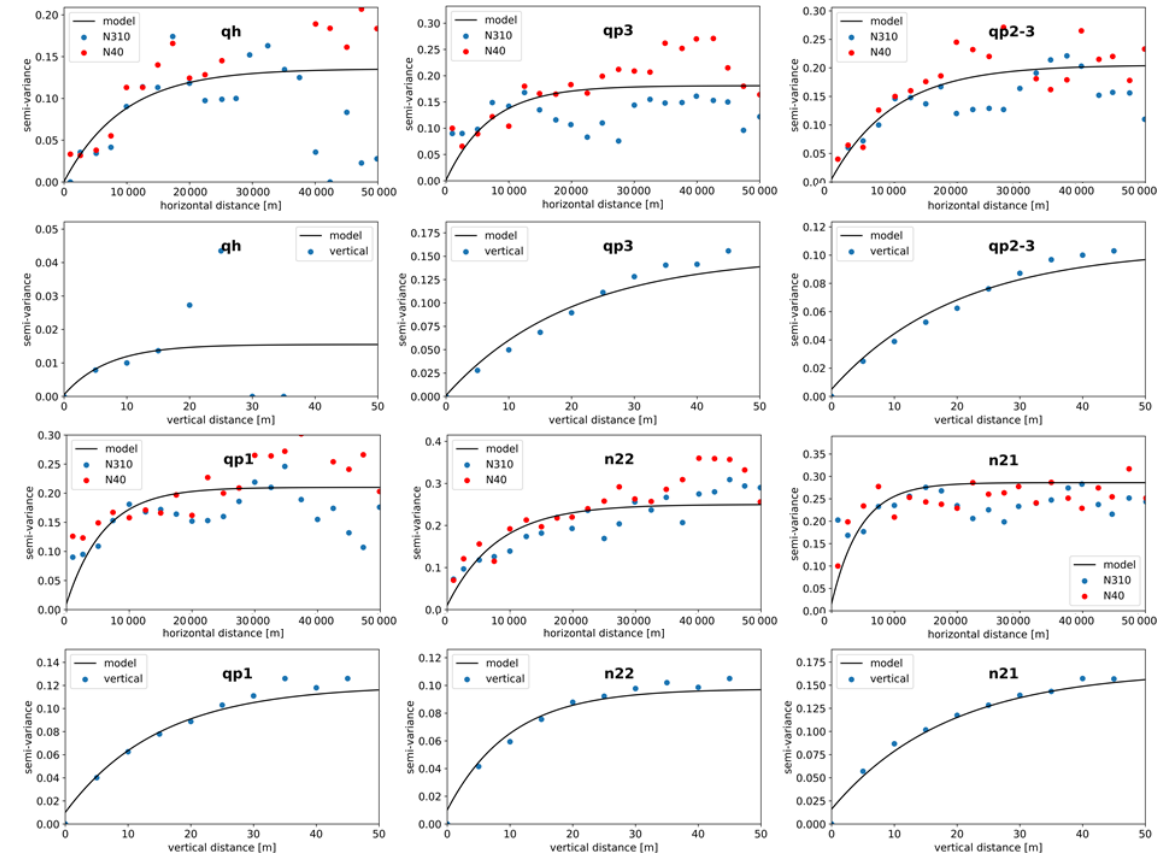
Figure E1. Horizontal and vertical experimental indicator semivariograms at indicator TDS = 1.0gL − 1 and fitted exponential semivari- ogram